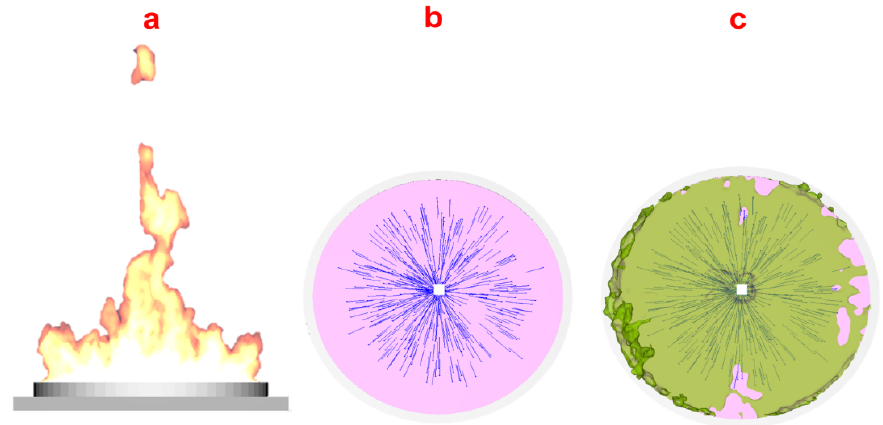
Figure 2. Three-dimensional geometry of the burning and suppressed pool fire. ( a ) Pool fire, ( b ) fire suppression by water, ( c ) fire suppression by the carbon dioxide (CO 2 ) mixture.